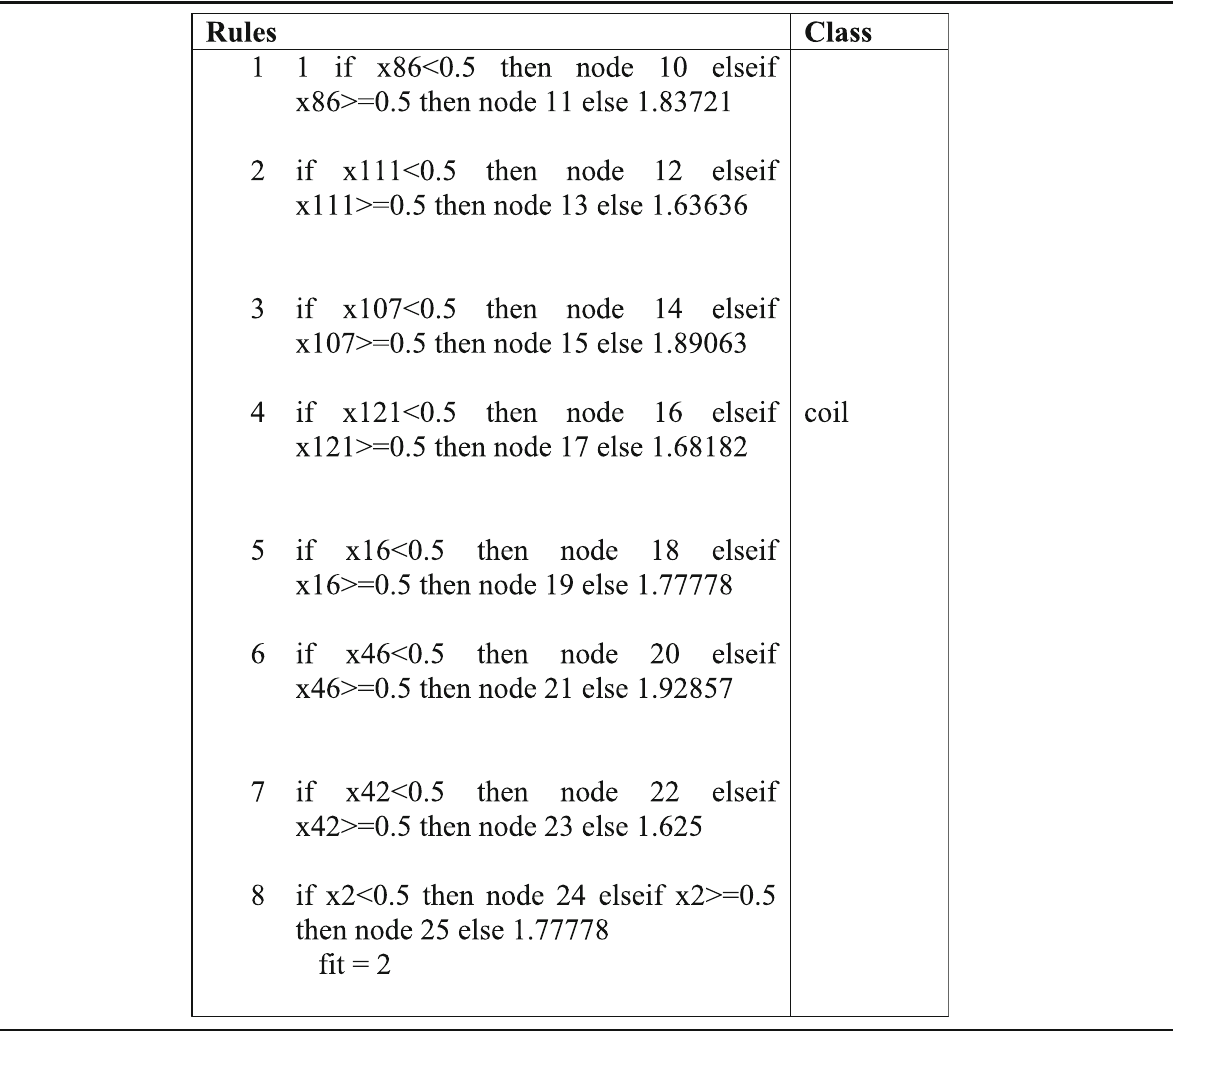
Table 6 Rules produced by the decision tree for the C/~C classifier